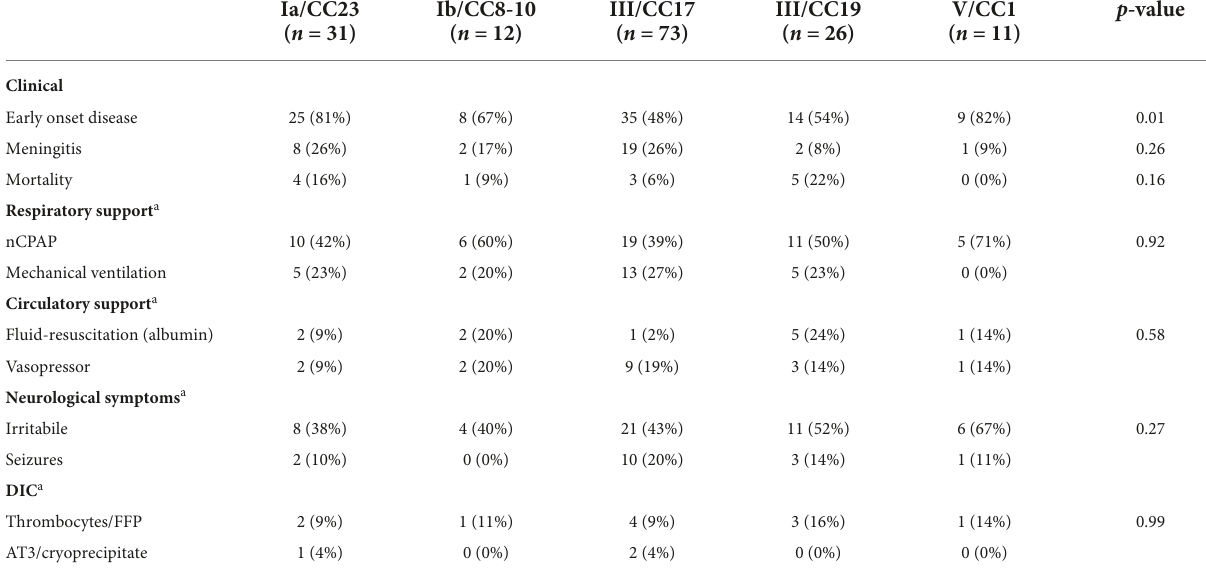
TABLE 2 Invasive Group B Streptococcus (GBS) strains from Danish infants within 3 months of life between 1999 and 2009 and their clinical